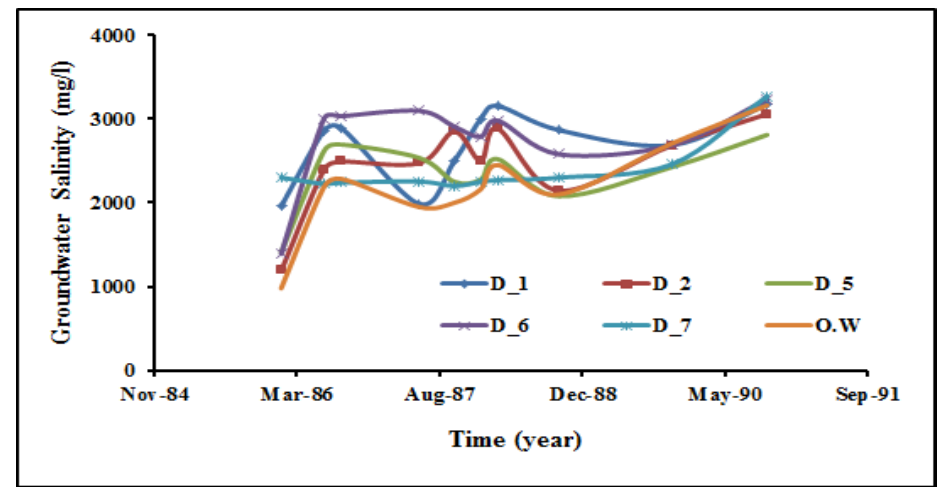
Figure 3. Historical record of groundwater salinity in the main well field of the Dahab delta (1986 to 1990). Site locations for these wells are indicated in Figure 2.